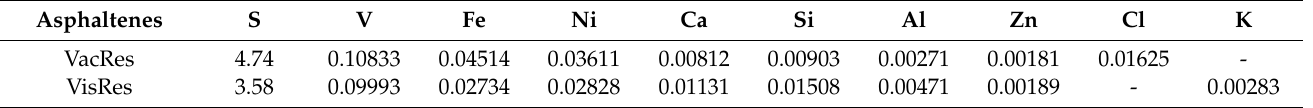
Table 2. The microelement composition of asphaltenes from VacRes and VisRes (% wt). Asphaltenes